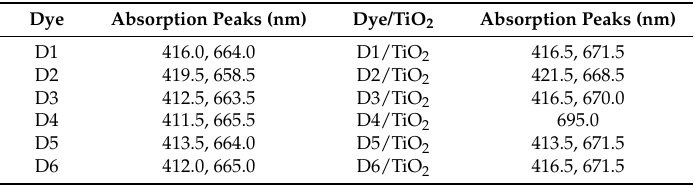
Table 1. Absorption peaks of isolated dyes and dye adsorbed on TiO 2